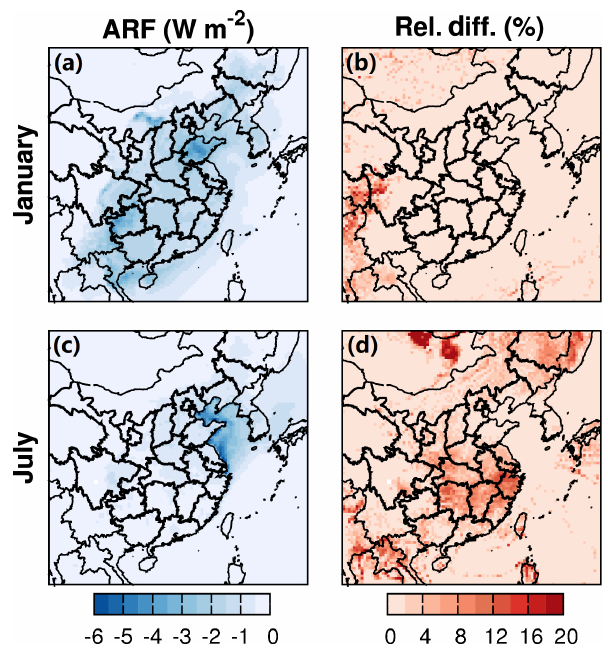
the fitted correlations are κ org = 1 − exp ( − ( O : C / 1 . 88 ) 2 . 29 ) and κ org = 1 − exp( − ( O : C / 1 . 06 ) 4 . 50 ) for January and July